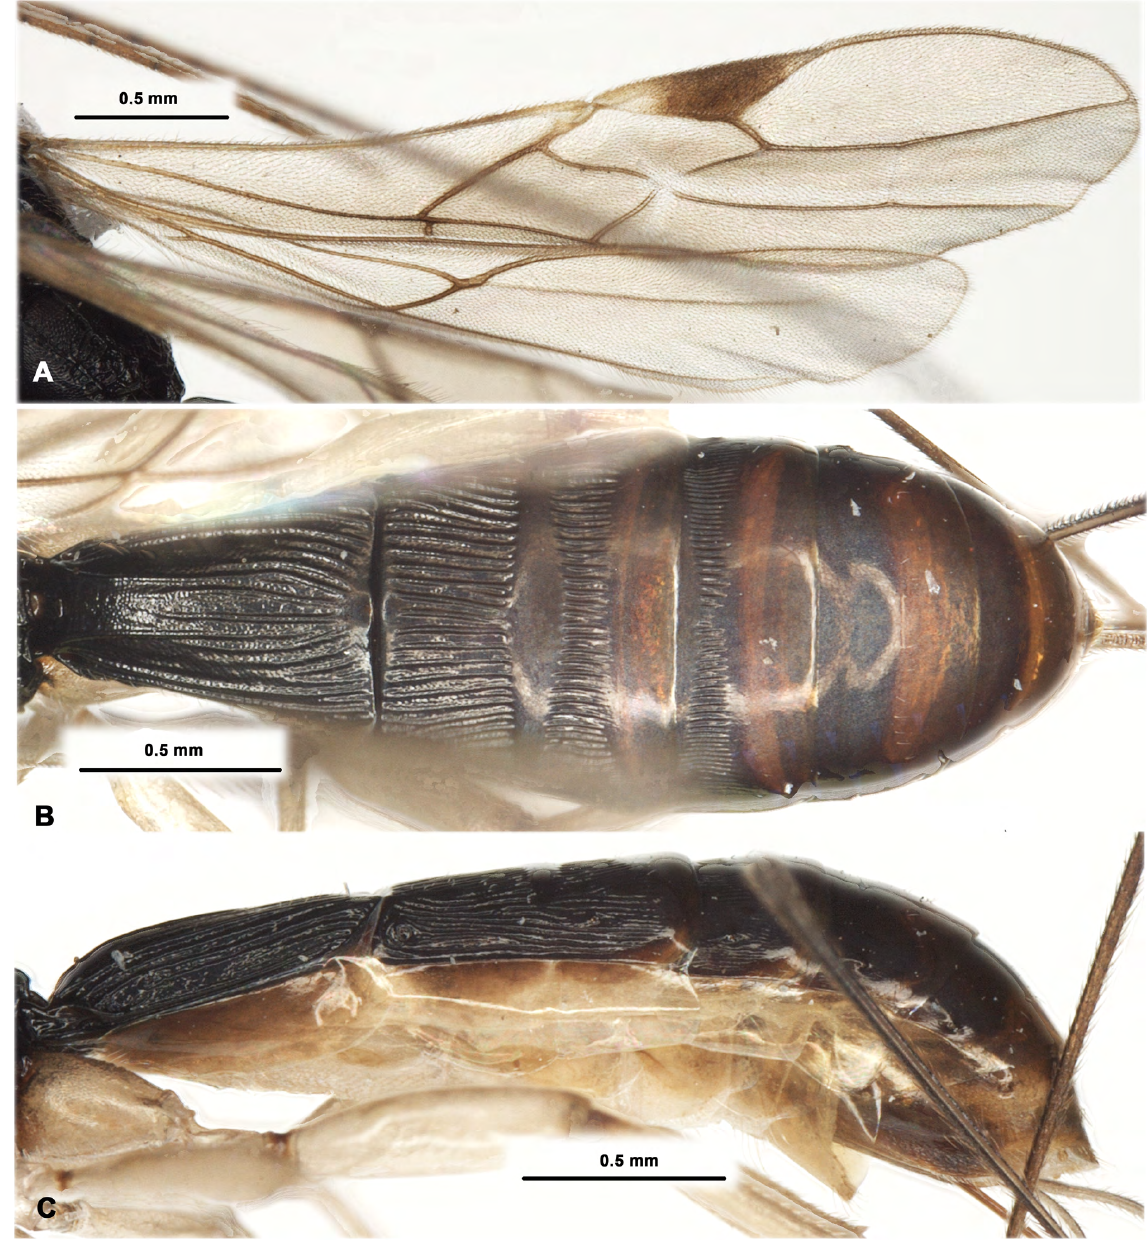
Fig. 57. Rhacontsira toamasina sp. nov., ♀, holotype, ZISP. A . Wings. B . Metasoma, dorsal view. C . Metasoma, lateral